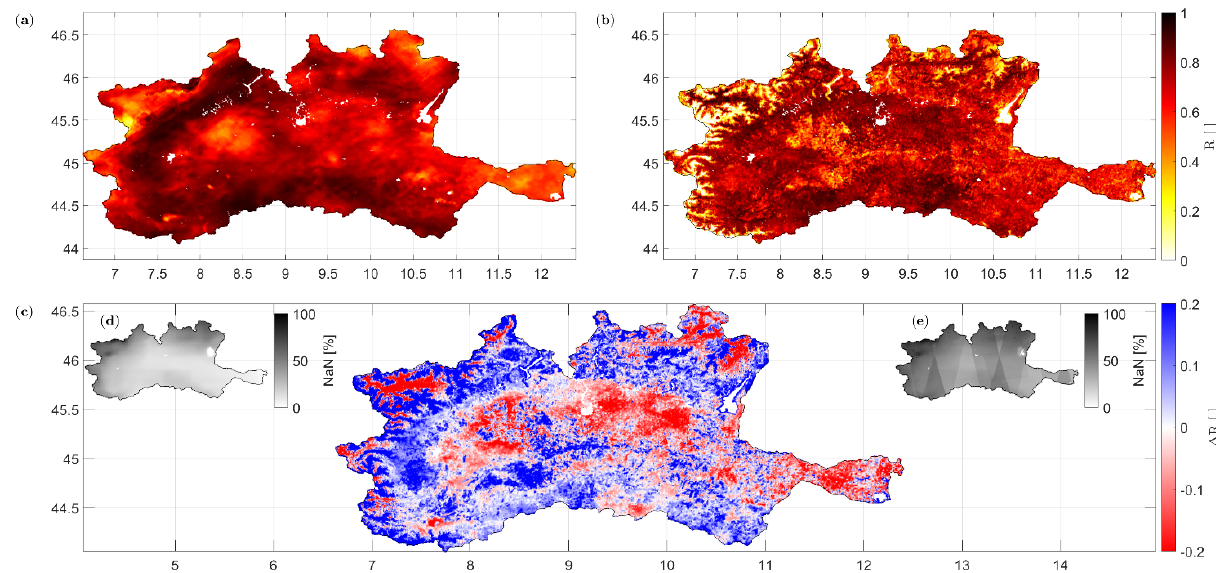
Figure 4. Spatial Pearson’s correlation ( R ) between the 30d accumulated rainfall derived from MCM and the application of the parameterized SM2RAIN to ASCAT (a) and to S1-RT1 (b) SM products. Panel (c) shows the difference between ASCAT and S1-RT1 correlation maps, while panels (d) and (e) show the percentage of invalid images per pixel respectively for ASCAT and S1-RT1.